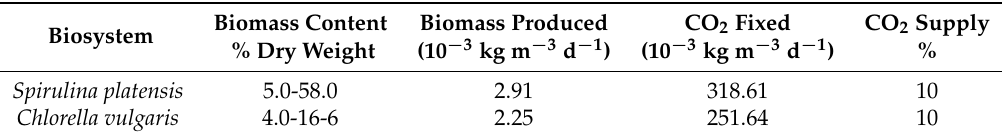
Table 2. Data for numerical evaluation